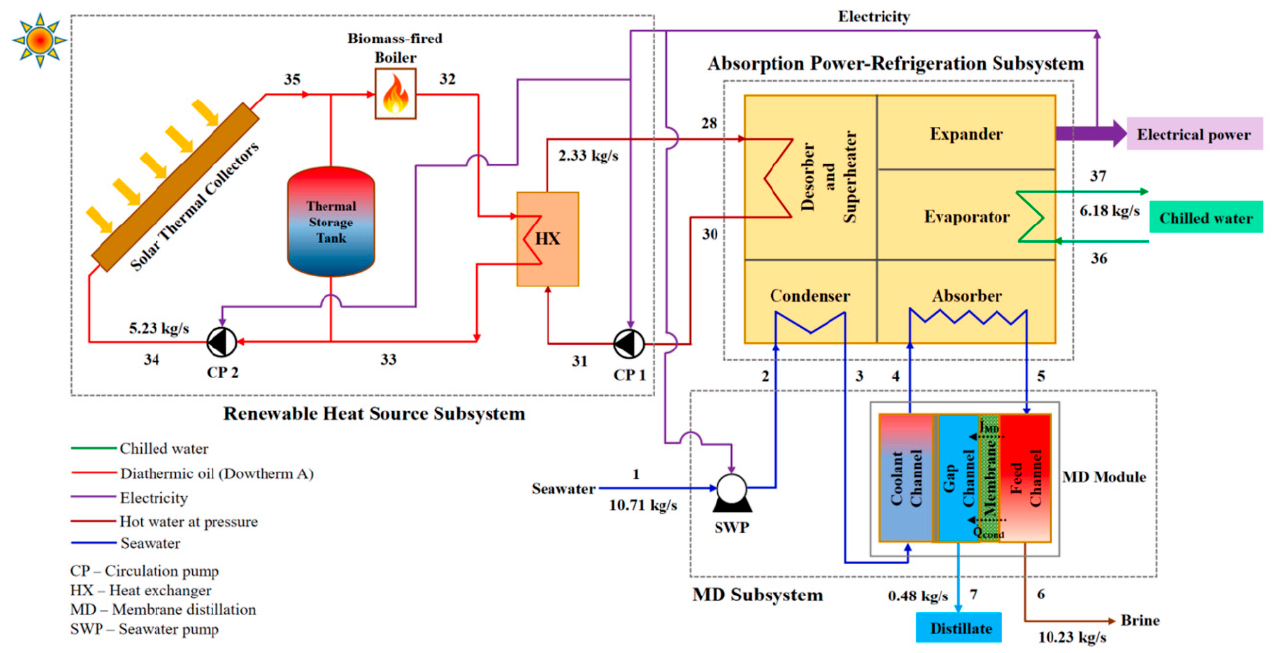
Figure 11. Schematic diagram of the hybrid solar-biomass polygeneration system, as proposed by Ayou et al. [98].